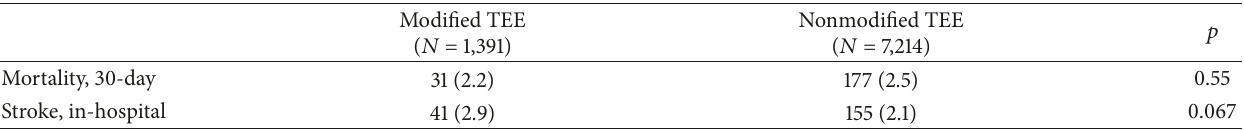
Table 4: Primary outcome measures comparing patients with and without perioperative screening with modified